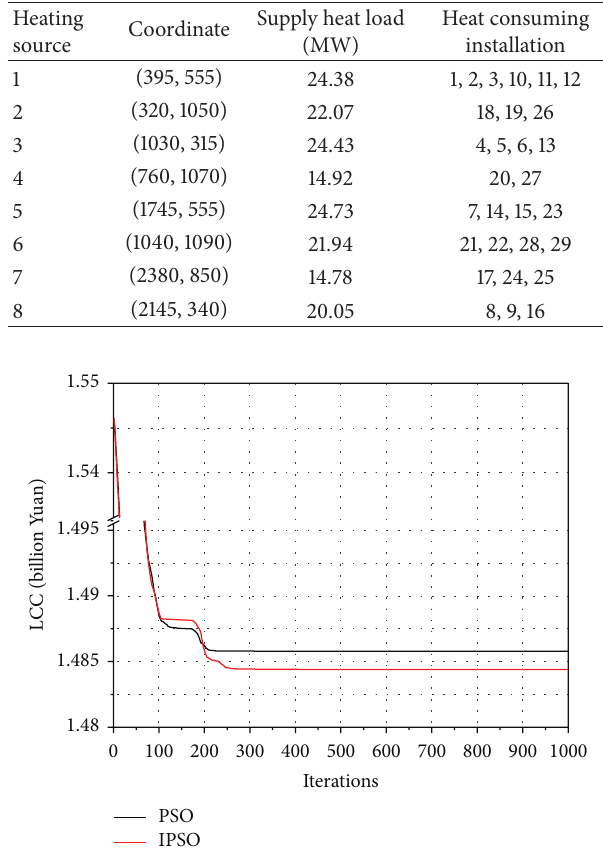
Figure 7: Algorithm calculation comparison (7 heat